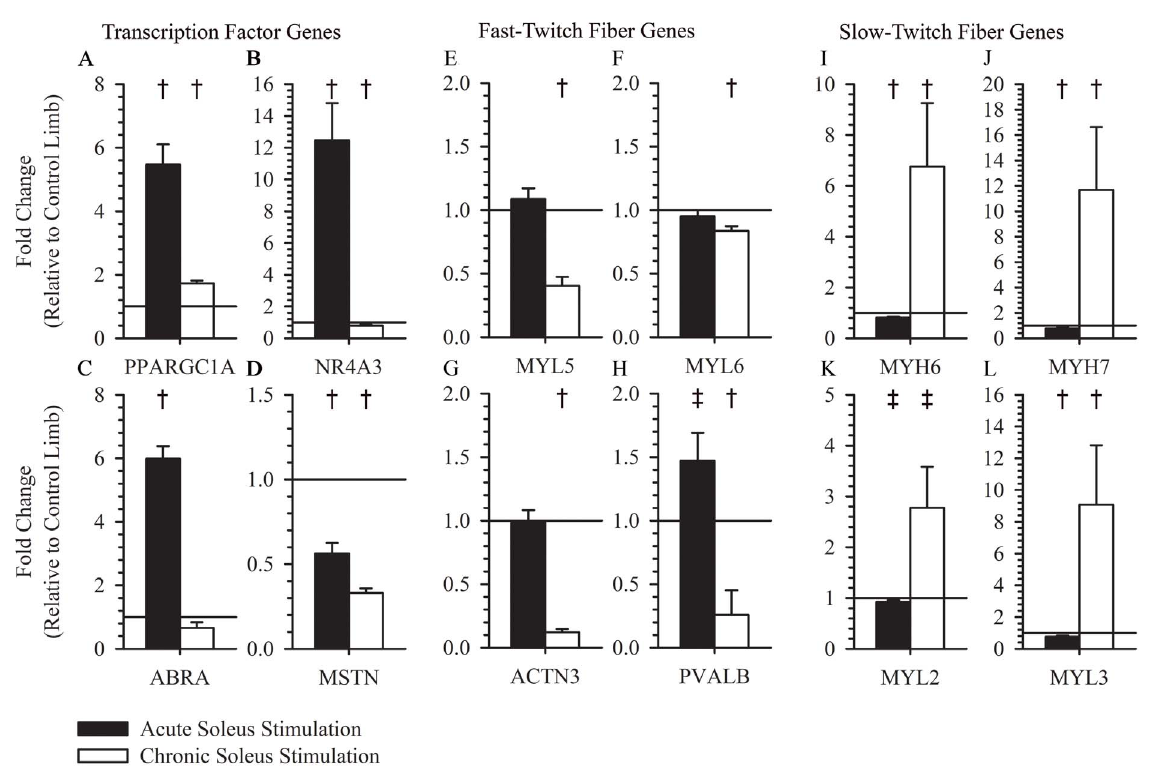
Fig. 3. Expression of transcription factor, fast-twitch fiber, and slow-twitch fiber genes following acute or chronic stimulation. PGC-1 a was increased 3 hours after a dose of muscle stimulation (5.46 ¡ 0.64, p , 0.001) and after . 1 year of muscle training (1.73 ¡ 0.09, p , 0.002) (A). NR4A3 was increased 3 hours after a dose of muscle stimulation (12.45 ¡ 2.36, p , 0.001), while it was decreased after . 1 year of muscle training (0.79 ¡ 0.06, p 5 0.046) (B). ABRA was increased after a single dose of muscle stimulation (5.98 ¡ 0.40, p , 0.001), but was unchanged after . 1 year of soleus training (0.66 ¡ 0.18, p , 0.16) (C). MSTN was decreased 3 hours after a dose of muscle stimulation (0.56 ¡ 0.06, p 5 0.002) and after . 1 year of muscle training (0.33 ¡ 0.03, p , 0.001) (D). MYL5 (0.040 ¡ 0.07, p 5 0.013), MYL6 (0.84 ¡ 0.038, p 5 0.030), and ACTN3 (0.12 ¡ 0.025, p 5 0.003) were all decreased after . 1 year of muscle training (E, F, and G). There was no difference detected 3 hours after a dose of muscle stimulation for MYL5 (1.09 ¡ 0.083, p 5 0.45). MYL6 (0.95 ¡ 0.048, p 5 0.32), and ACTN3 (0.99,0.095, p 5 0.72) (E, F, and G). PVALB was increased after a single dose of muscle stimulation (1.47 ¡ 0.22, p 5 0.074), but was decreased after . 1 year of muscle training (0.26 ¡ 0.19, p 5 0.047) (H). MYH6 (6.76 ¡ 2.50, p 5 0.030), MYH7 (11.69 ¡ 4.93, p 5 0.025), MYL2 (2.78 ¡ 0.80, p 5 0.063), and MYL3 (9.07 ¡ 3.75, p 5 0.046) were increased after . 1 year of muscle training, while they were decreased 3 hours after single session of muscle stimulation (0.81 ¡ 0.04, p 5 0.0073, 0.77 ¡ 0.073, p 5 0.030, 0.92 ¡ 0.036, p 5 0.066, 0.76 ¡ 0.078, p 5 0.037; respectively) (I, J, K, and L). { indicates a p-value , 0.05 for a within group paired t-test. { indicates a p-value , 0.10 for a within group paired